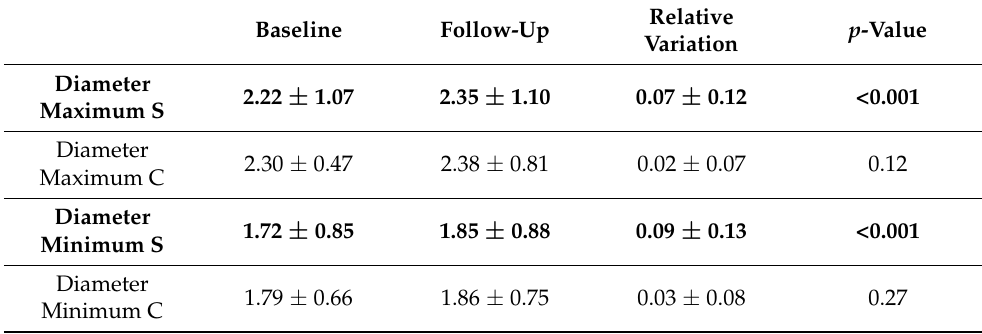
Table 2. Mean and standard deviation (SD) of diameters of 456 analyzed nevi. Table 3. Mean and standard deviation (SD) of 222 nevi analyzed.